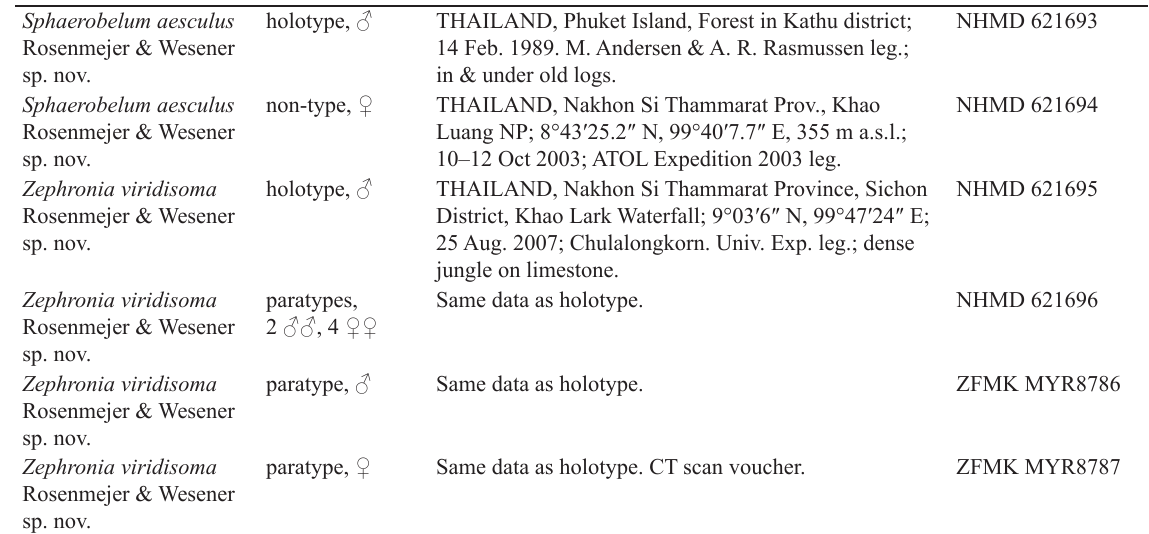
Table 1. Morphologically analysed